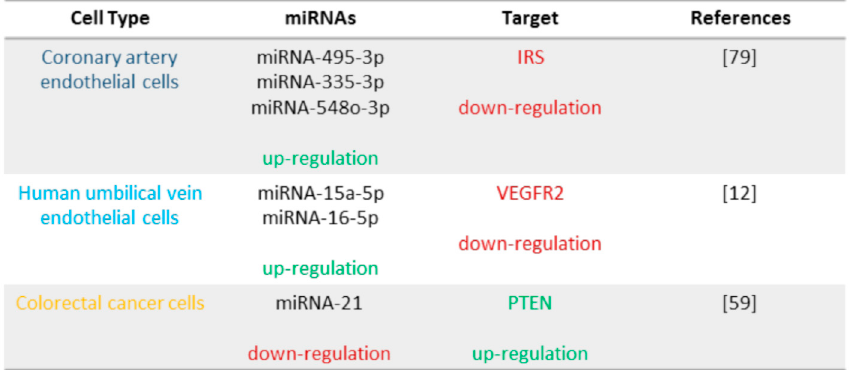
Figure 7. TFEB regulation of miRNA expression.